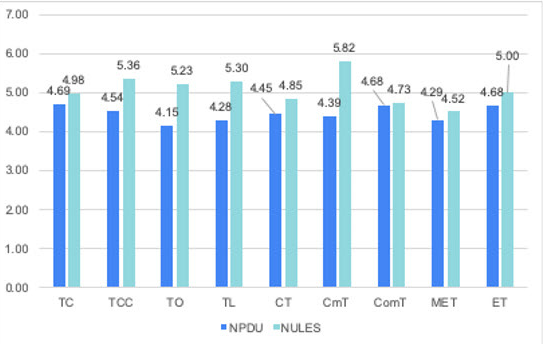
Figure 5. Comparison of trust domains between employees of the NPDU and the NULES